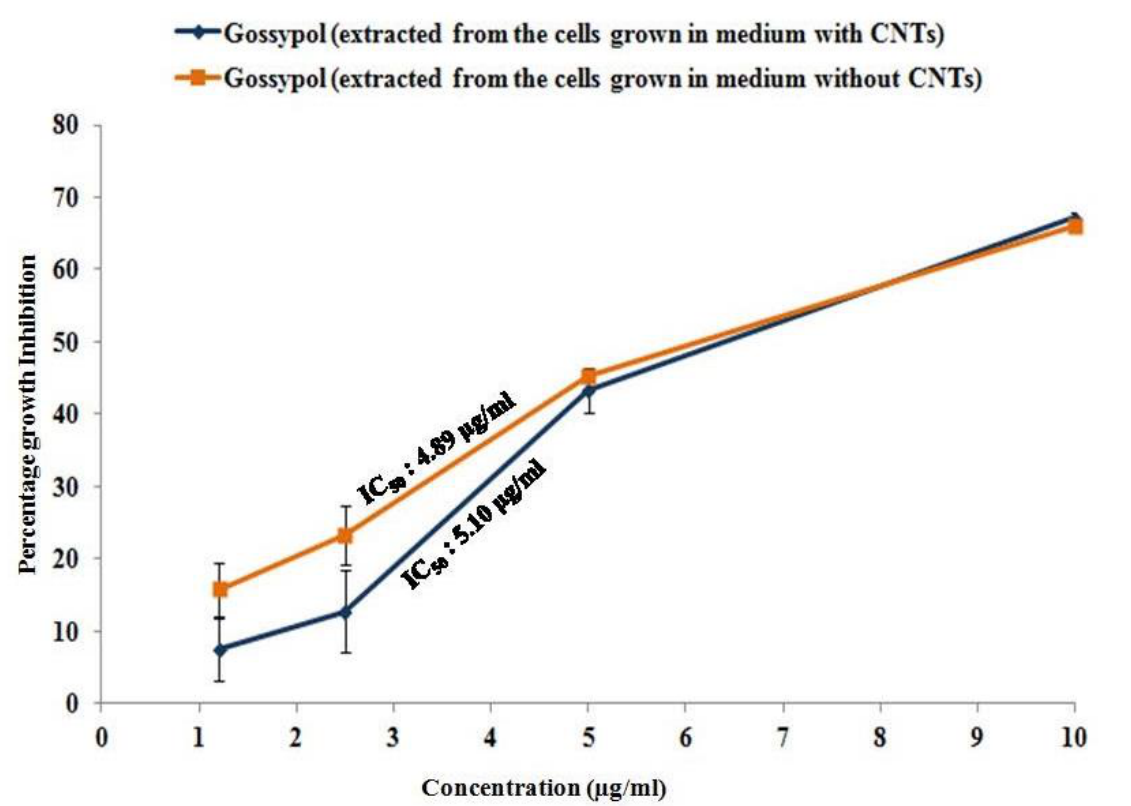
Figure 4. Antiproliferative activity of gossypol produced by cell suspension culture against prostate cancer cell line PC-3. Graph showing the percentage growth inhibition of cancerous cells.